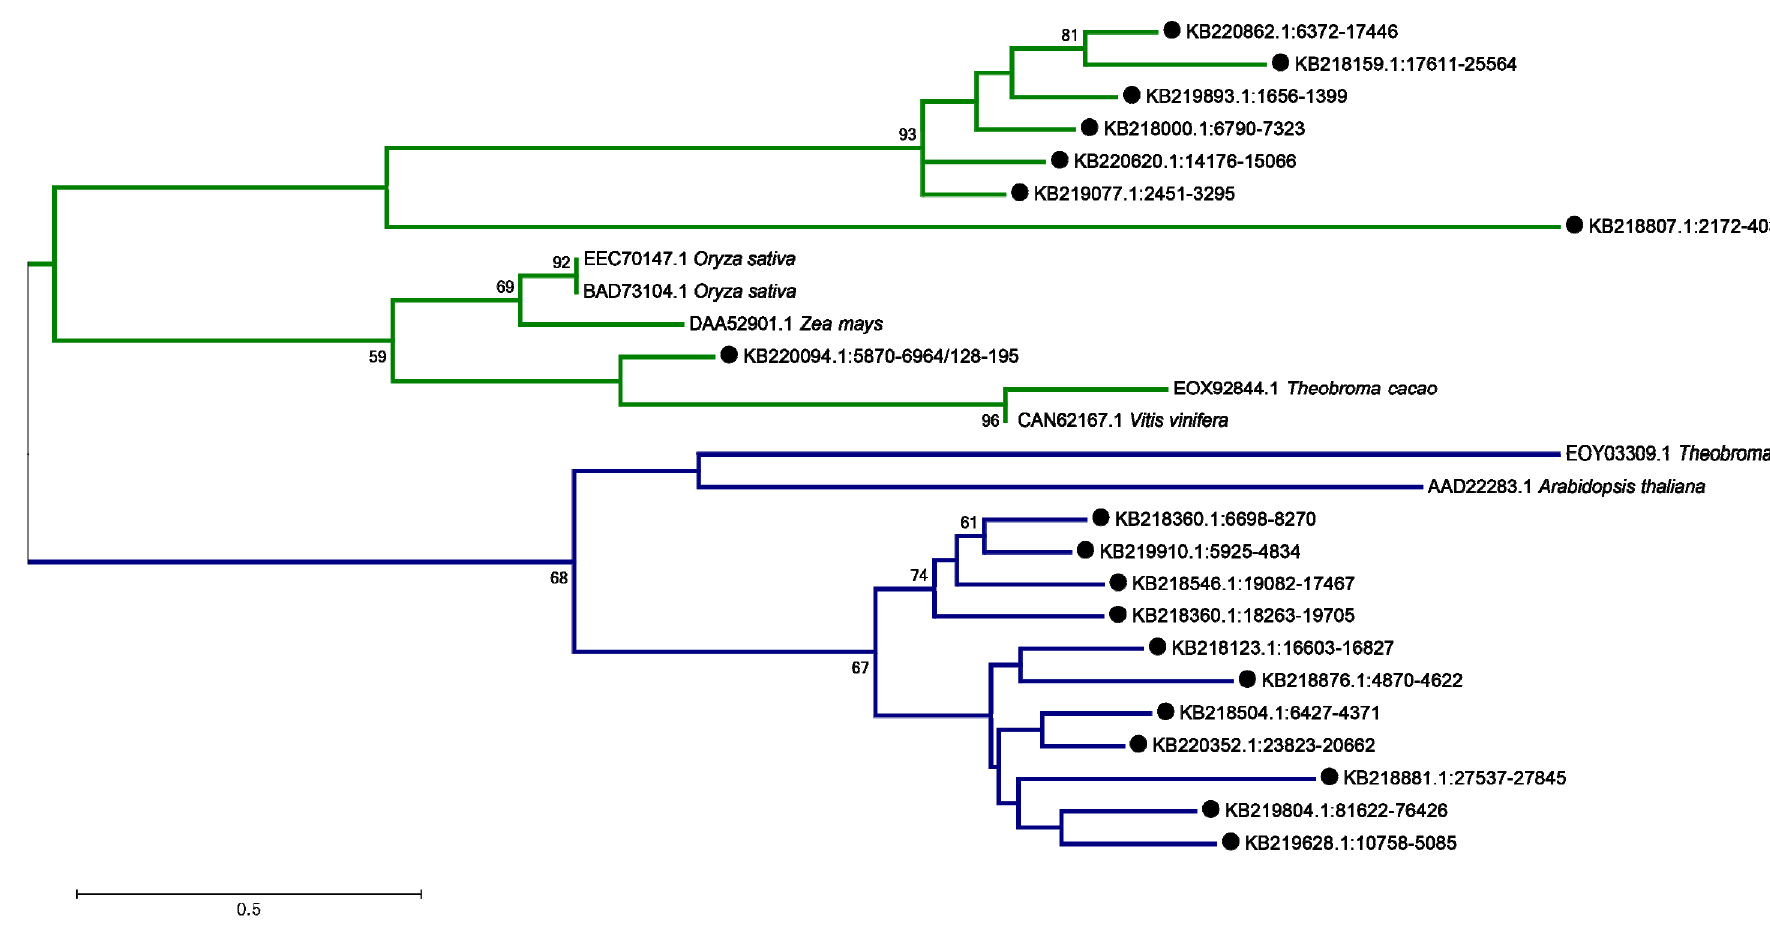
Figure 7. Maximum-Likelihood phylogenetic tree for enset integrase core-domain proteins. Proteins sequences from E. ventricosum are indicated by circles. The sequence from M. acuminata is indicated by a diamond. Bootstrap values of greater than 50% are indicated as numbers on the